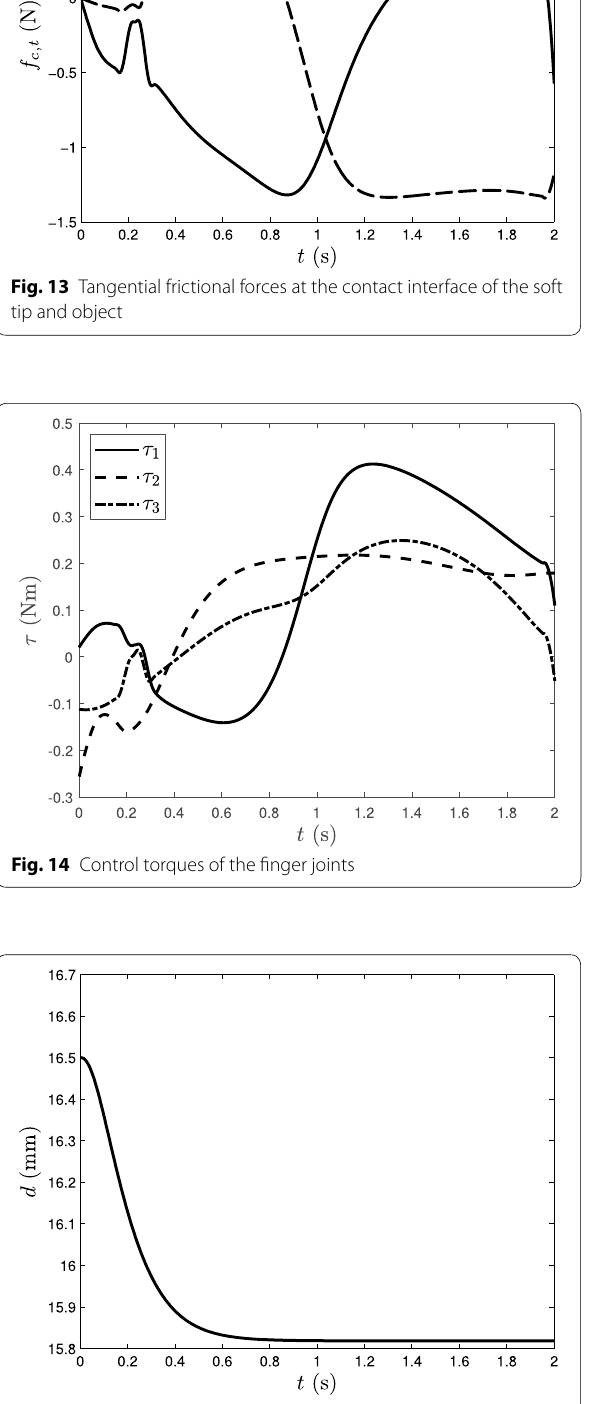
Fig. 15 Deformation of the soft tip during manipulation